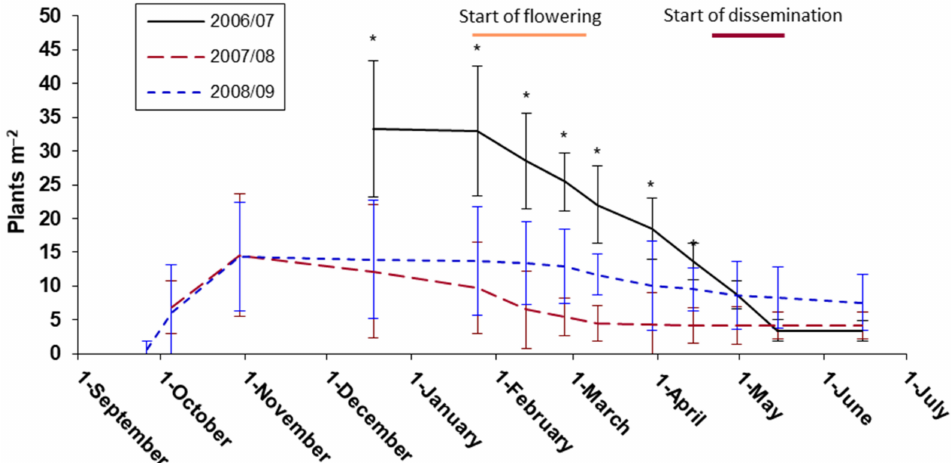
Figure 1. Average population density throughout the three studied periods. Asterisks indicate those dates in which significant differences between years were obtained ( p < 0.05). Bars are standard errors. The periods of beginning of flowering and seed dispersal are also